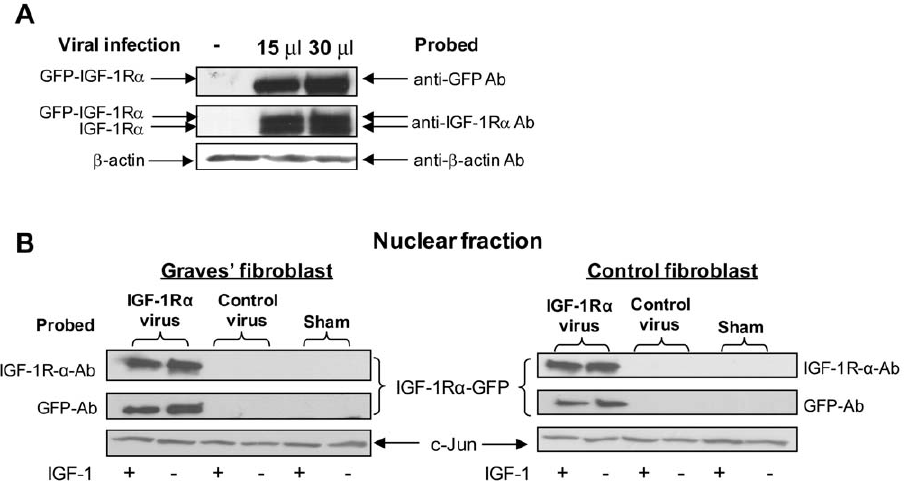
Figure 6. Virally encoded IGF-1R a -GFP fusion protein expression in GD and control orbital fibroblasts. ( A ) Expression of the adenovirus-encoded IGF-1R a –GFP fusion protein can be detected by Western blot analysis probed by both anti-GFP and anti-IGF-1R a . ( B ) IGF-1R a - GFP fusion protein accumulates in the nuclei of both control and GD orbital fibroblasts, as assessed by Western blot analysis following subcellular fractionation of nuclear protein. IGF-1 treatment fails to alter this pattern. These studies are representative of 5 experiments involving expression of virally encoded IGF-1R a .